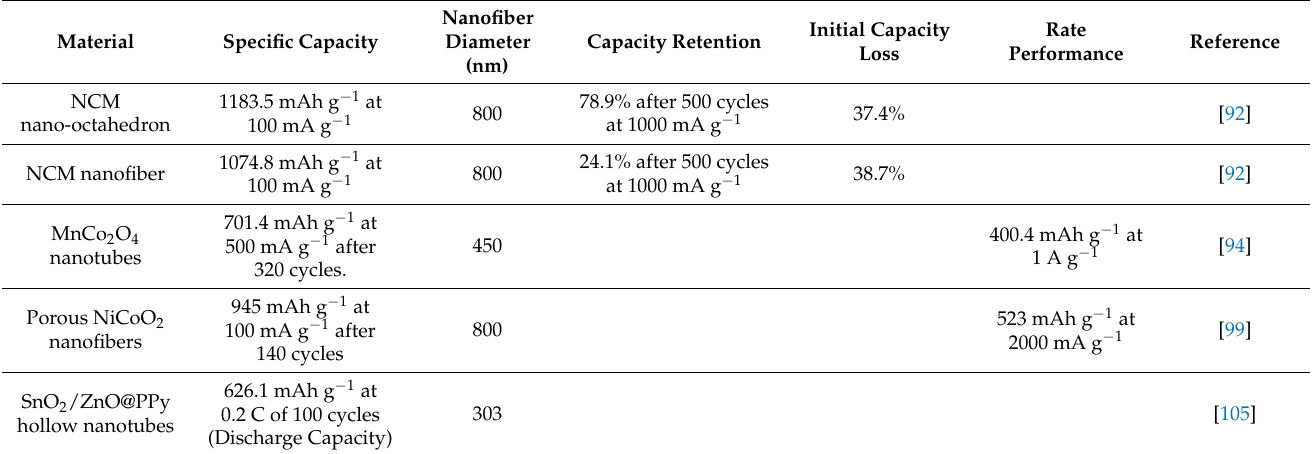
Table 3. Electrochemical properties of advanced anode material exhibiting conversion stor- age